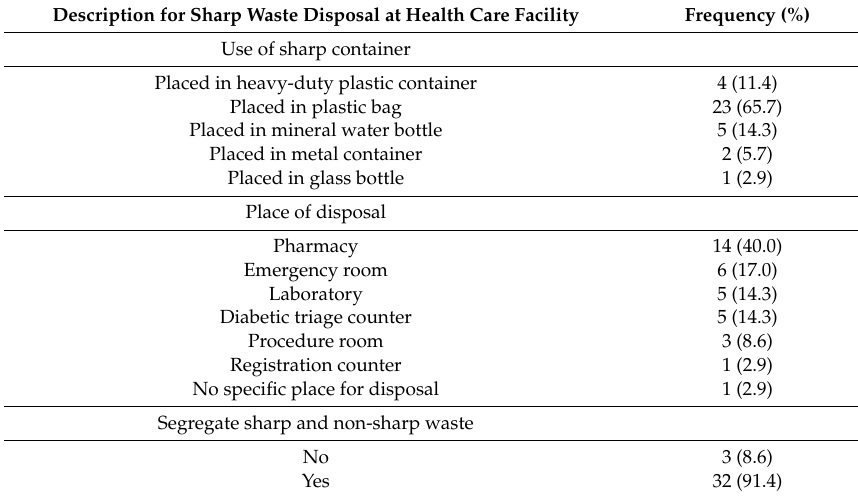
Table 3. Description for sharp waste disposal at health care facility ( n =